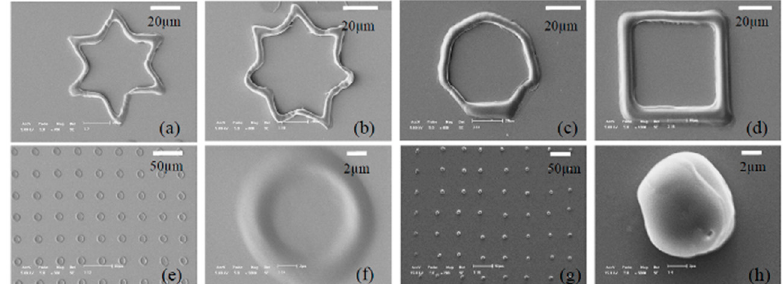
Figure 14. SEM images of poly (ethylene glycol) (PEG)-diacrylate (PEGDA)-based micro/nanostructures fabricated using optically-projected spot patterns with different exposure times. The heights in ( a – f ) measured by AFM were 233 nm, 455 nm, 687 nm, 950 nm, 1.34 μ m, and 1.62 μ m, respectively (reproduced from Ref. [80]).